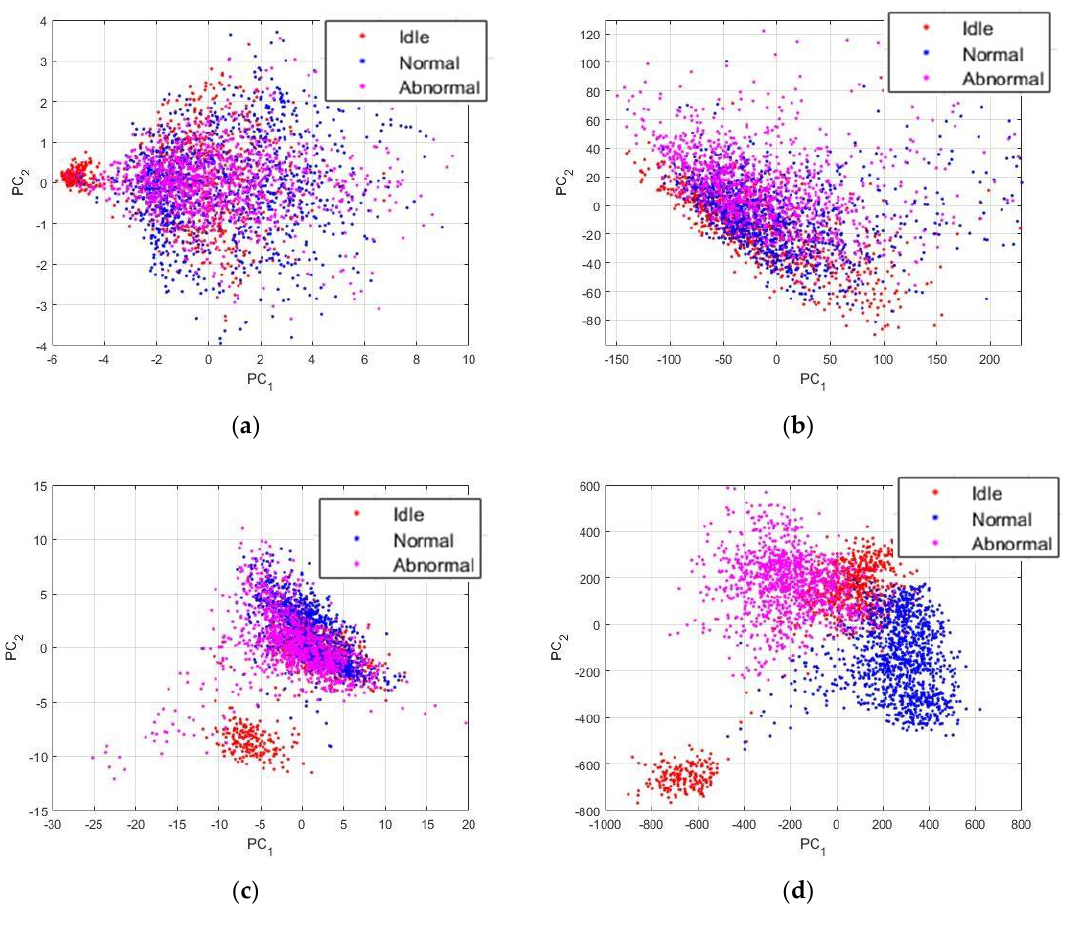
Figure 20. Projections of the data using different feature representation: ( a ) the statistical features computed using the continuous wavelet transform (CWT); ( b ) the Hilbert-Huang transform (HHT) components; ( c ) the wavelet packets (WP); and, ( d ) the short-time Fourier transform (STFT) components.